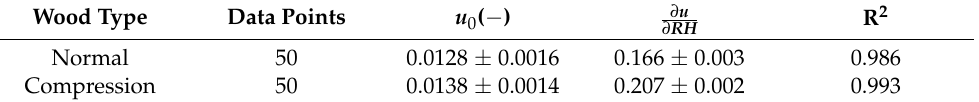
Table 1. Average linearized sorption isotherms u ( RH ) = u 0 + ∂ u normal wood and compression wood.